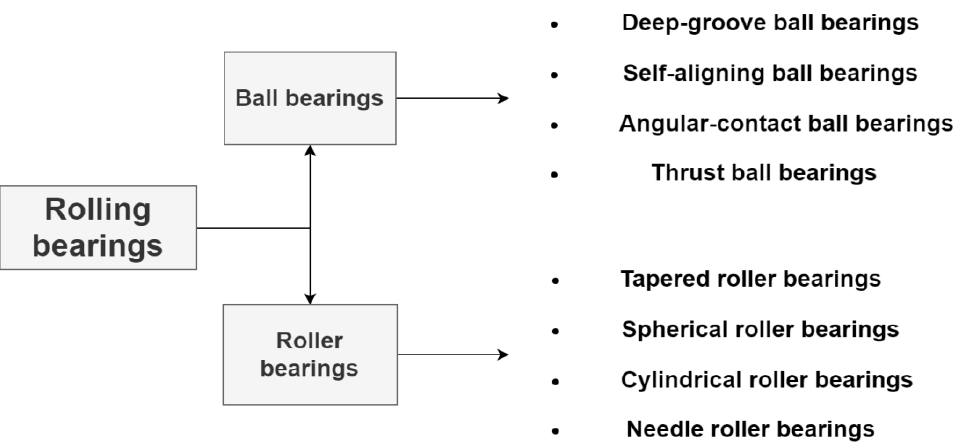
Figure 2. The major classifications of rolling bearings.